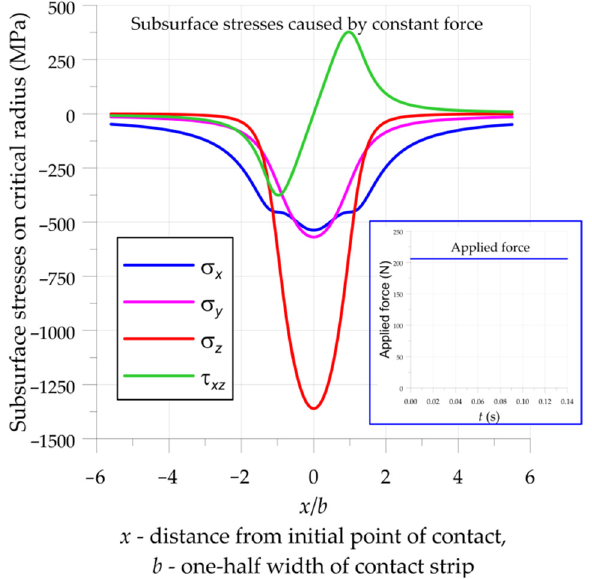
Figure 3. Subsurface stresses in the investigated cylindrical roller thrust bearing on critical radii in a bearing subjected to constant force (the force acting on one roller is F = 206 N).